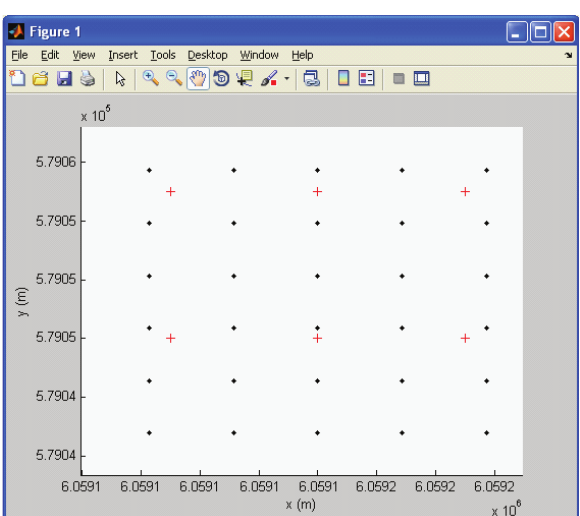
Table 1. The estimated dispersion of height data interpolated by Geo3D and WinSurf programs Interpoliavimo